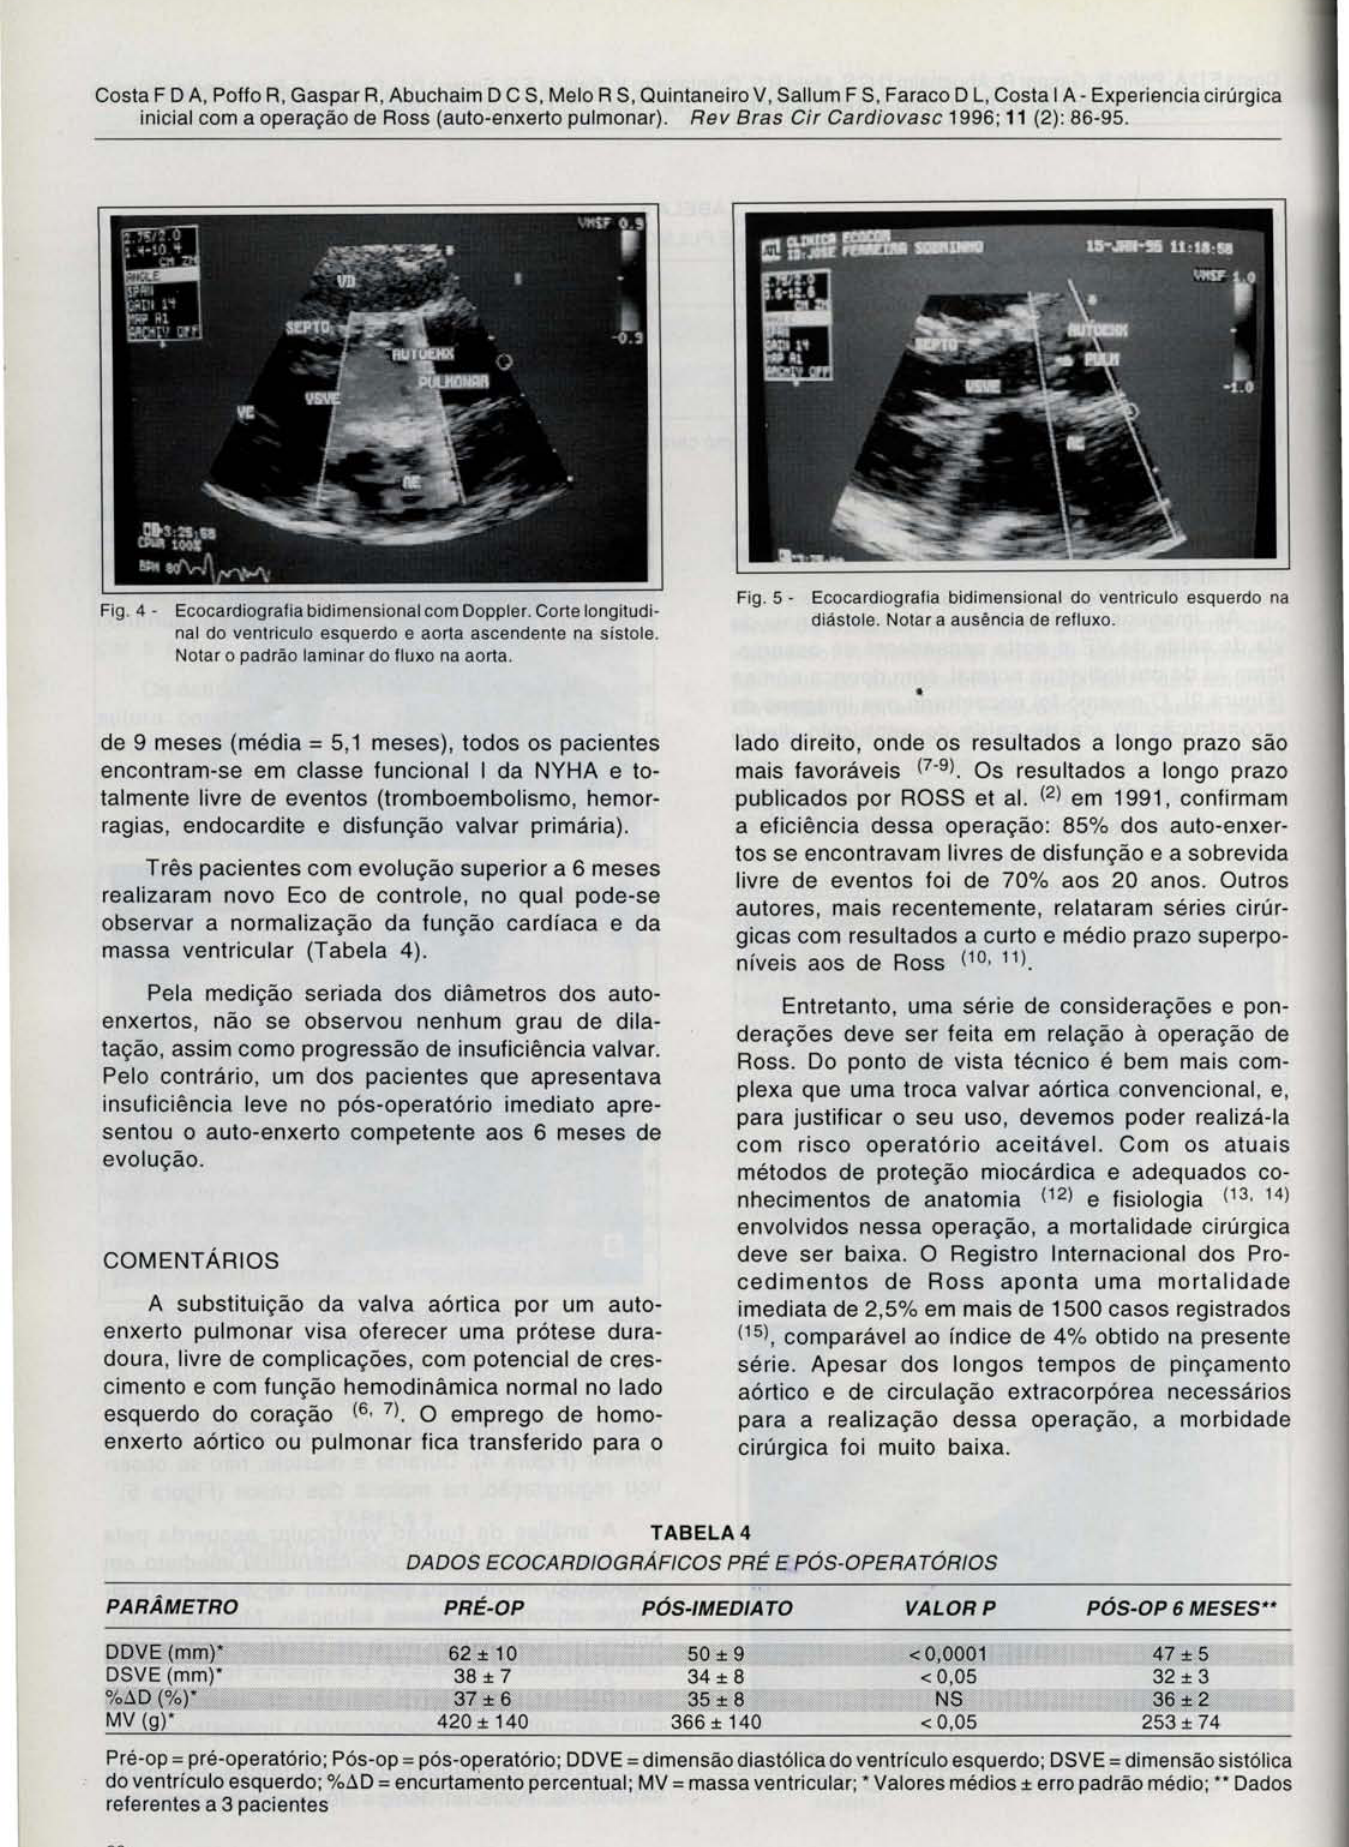
Fig. 5 - Ecocardiografia bidimensional do ventriculo esquerdo na diástole. Notar a ausência de